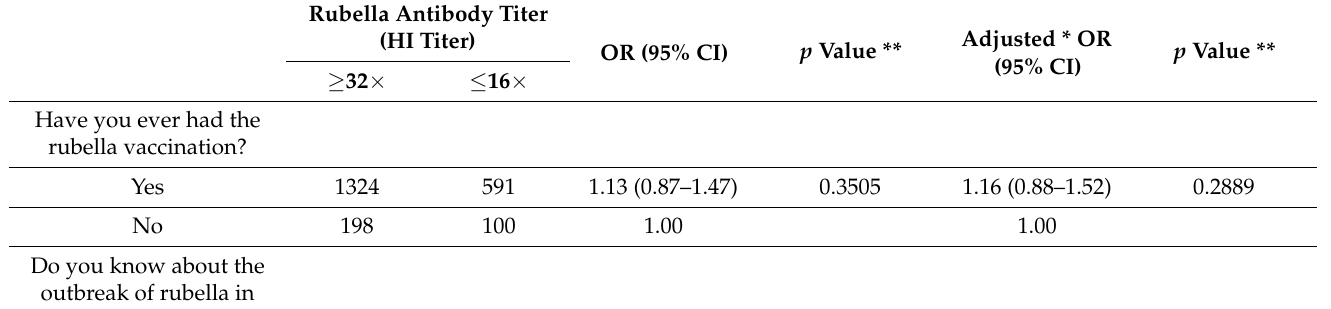
Table 3. Cont . Rubella Antibody